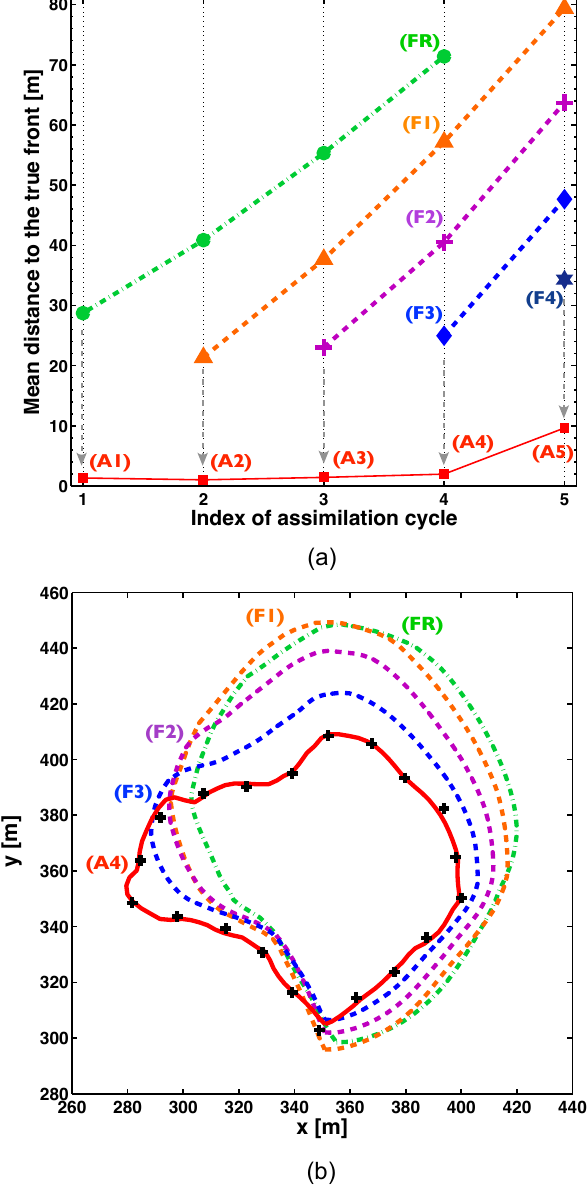
Figure 12. OSSE anisotropic case over multiple assimilation cy- cles (from 0 to 600s). (a) Average distance between the true and forecast/analysis fire front location as a function of the assimila- tion cycle index: green circles correspond to the free run (FR); tri- angles, crosses, diamonds and stars correspond to a forecast with an EnKF update at t 1 = 150s (F1), t 2 = 300s (F2), t 3 = 450s (F3) and t 4 = 600s (F4), respectively; square symbols correspond to an EnKF update performed at times t 1 (A1), t 2 (A2), t 3 (A3), t 4 (A4) and t 5 (A5). (b) Comparison at time t 4 = 600s between the free run (FR) in green dashed-dotted line, the mean forecast estimate (F1, F2, F3) in dashed lines, observations in black crosses, and the mean analysis estimate (A4) in red solid line.